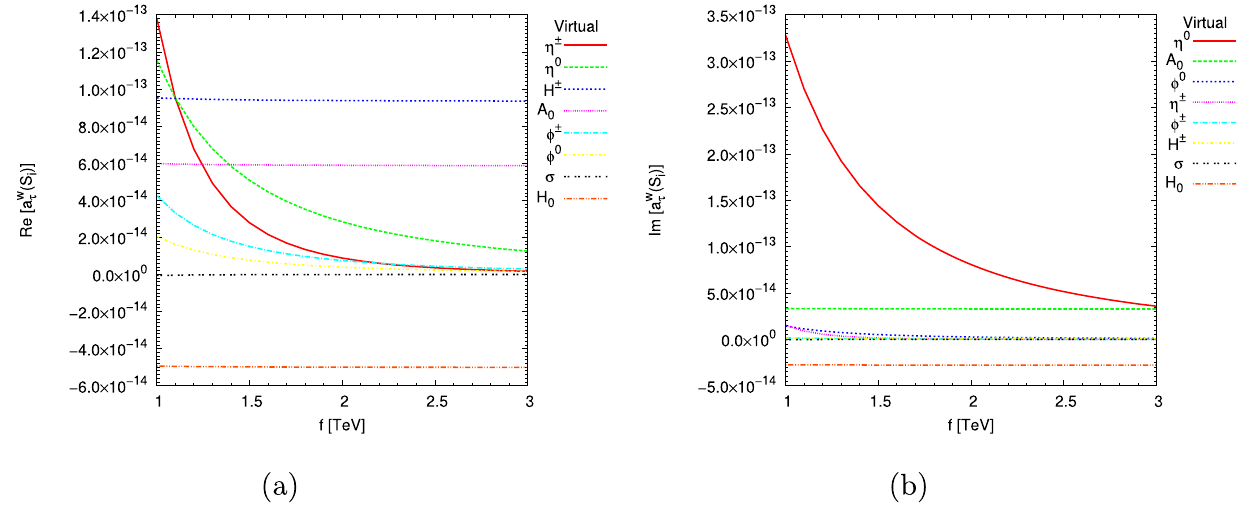
Fig. 7 Individual scalar contributions to a W τ . a Re( a W τ ). b Im( a W τ ). The plots are obtained with the fixed value of F = 4000 GeV. The values provided in Table 3 are used for the remaining model parameters